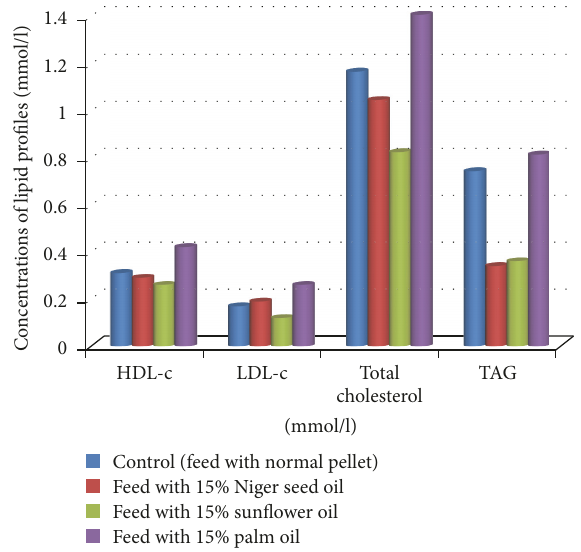
Figure 1: The comparisons of the mean values of total cholesterol, TAG, HDL-c, and LDL-c of blood serum at the end of study period.